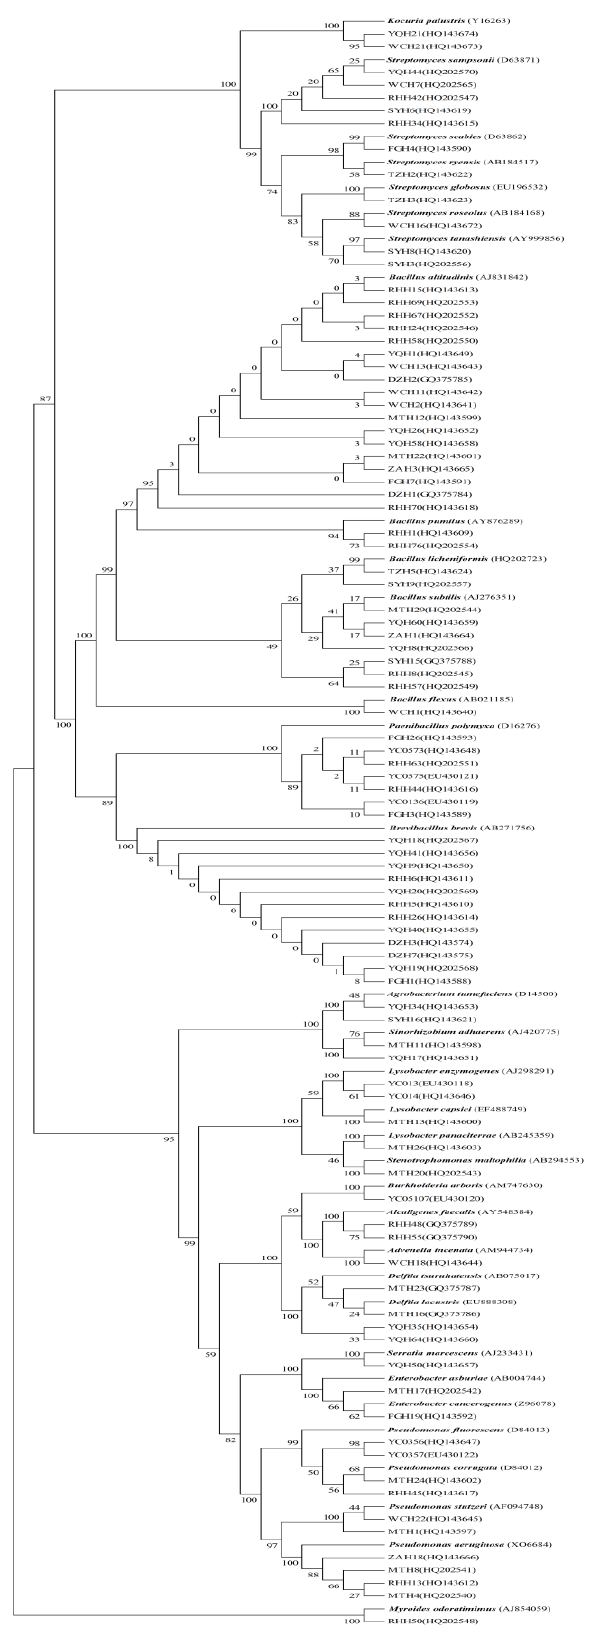
Figure 5. A neighbor-joining phylogenetic tree based on 16S rRNA gene sequences of antagonistic bacteria. The tree contains the closest type strain for each isolate. Bootstrap analyses were made with 1000